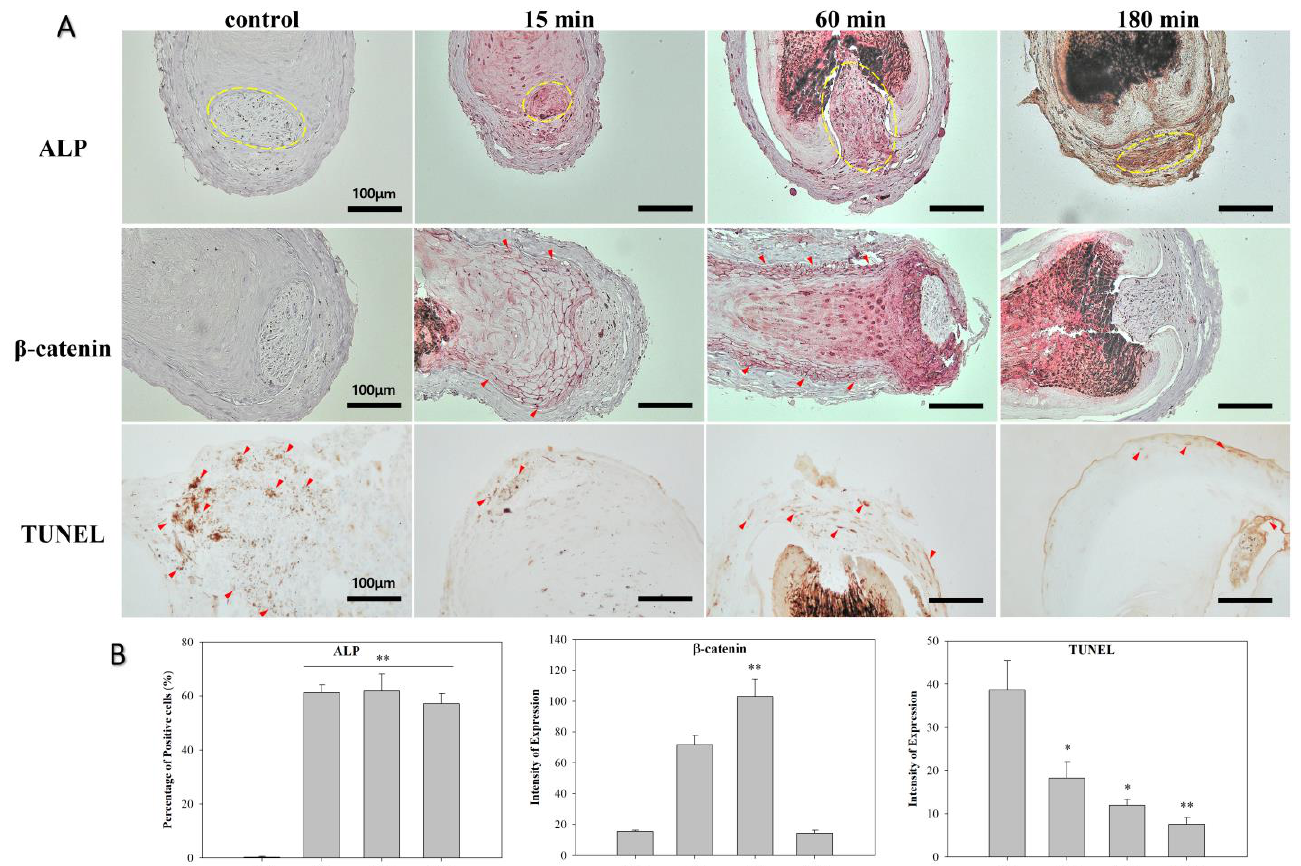
Figure 7. Immunohistochemical staining of ALP, β -catenin, and TUNEL in the hair follicles (HFs) after treatment with ELF-EMF for 14 days. Scale bar: 100 µ m. The arrows indicate positive staining. The dotted lines indicate dermal papilla. Original magnification: 200 × . Scale bar: 100 µ m. ( B ) Percentage of positive cells (ALP) or intensity of expression ( β -catenin and TUNEL) in ( A ). The values were calculated using QuPath software. Each bar represents the mean ± standard error of independent experiments performed in triplicate ( n = 3). Significant differences were determined via the non- parametric Kruskal – Wallis test; * p < 0.05, ** p < 0.01.